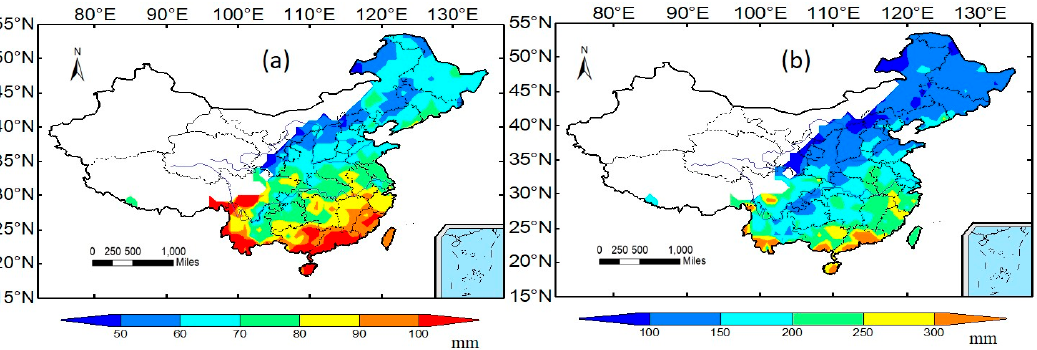
Figure 2. Flood-causing critical precipitation (( a ) AP_HRP 60% , unit: mm) and serious flood-causing critical precipitation (( b ) AP_HRP 95% , unit: mm) in China from 1981 to 2010.